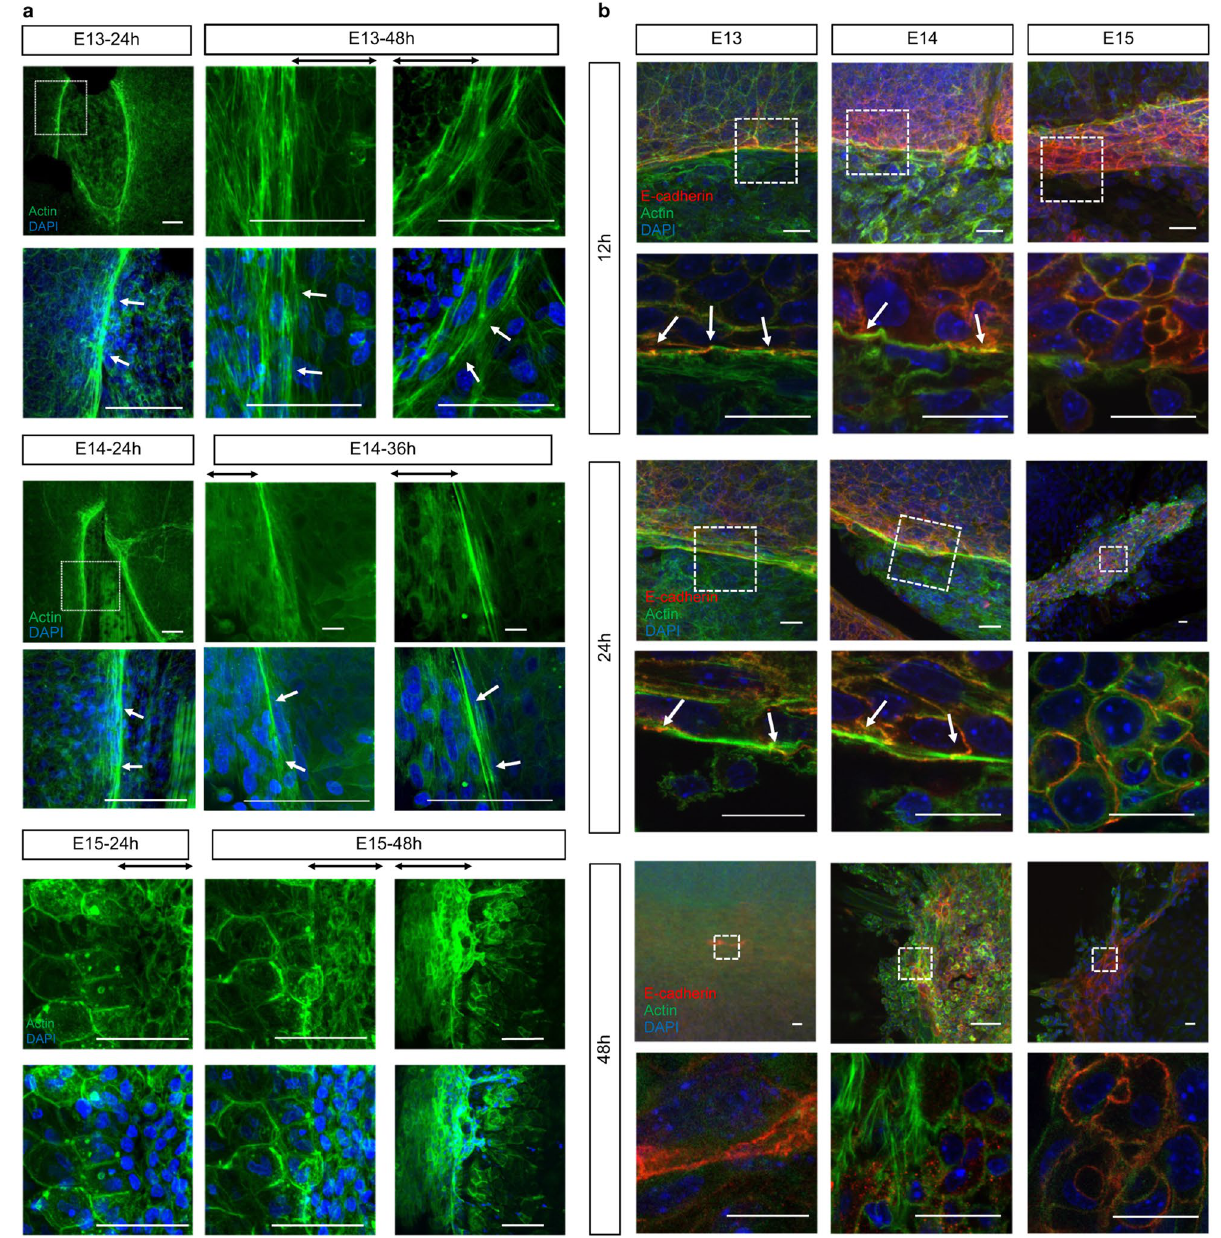
E14, but not at E15. Green: actin; blue: DAPI. ( b ) Actin cables and E-cadherin expression at 12, 24, and 48 h after wounding at E13–15. Anchoring by E-cadherin was observed at the wound site and during actin cable formation. Green: actin; red: E-cadherin; blue: DAPI. Scale bar = 20 µm. ( C ) TEM images of E13–15 wounds after 24 h. The wound is indicated by red arrows, and the actin cables are indicated by yellow arrows. Scale bar = 4